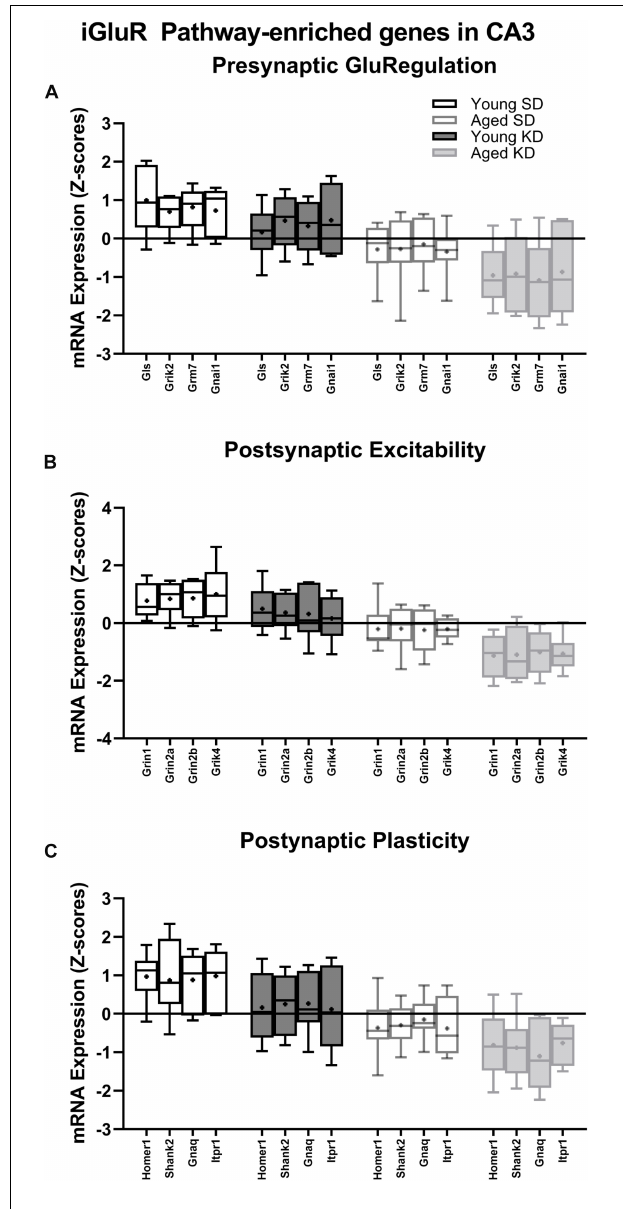
FIGURE 6 | Genes within the ionotropic glutamate receptor (iGluR) pathway reliably changed with age within CA3. (A) 4 genes associated with presynaptic glutamate regulation were reduced as a function of age. (B) 4 genes associated with postsynaptic excitation were reduced as a function of age. (C) 4 genes associated with postsynaptic plasticity were reduced as a function of age. Black bars represent young; gray bars represent aged; open bars represent standard diet; and filled bars represent ketogenic diet. Boxes represent the upper and lower quartiles around the median, the whiskers are the minimum and maximum observed values and +indicates the group